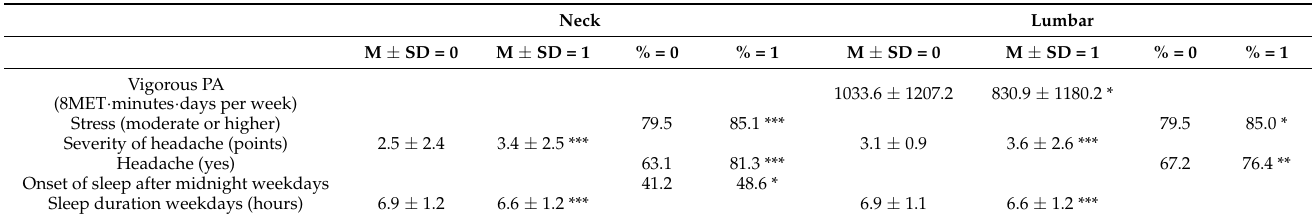
Table 2. Comparison of lifestyle parameters and health aspects in subgroups of people with and without complaints in the neck region or lumbar spine before the pandemic (only statistically significant differences are presented).